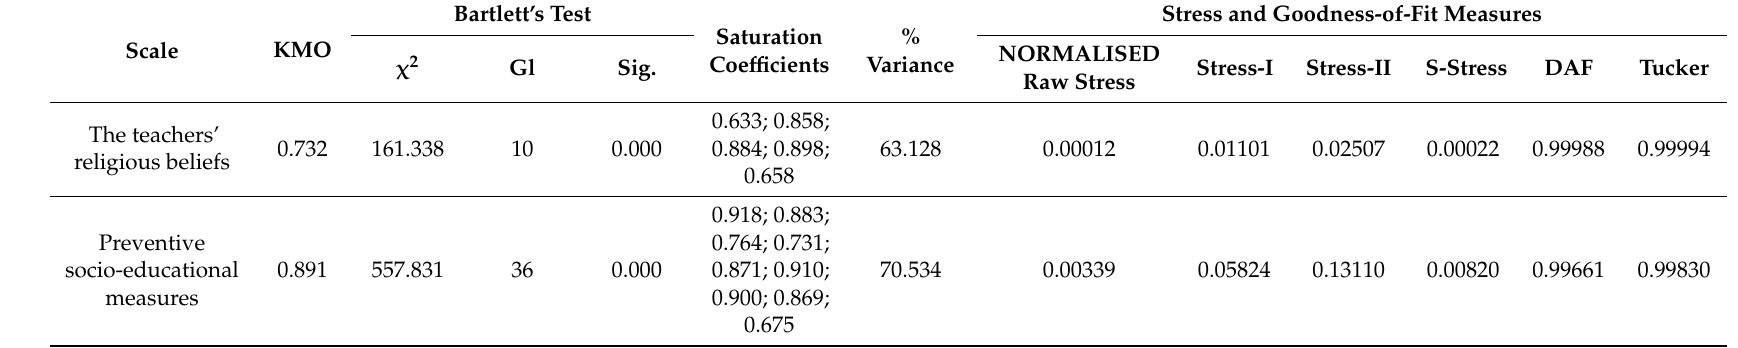
Table 2. Construct